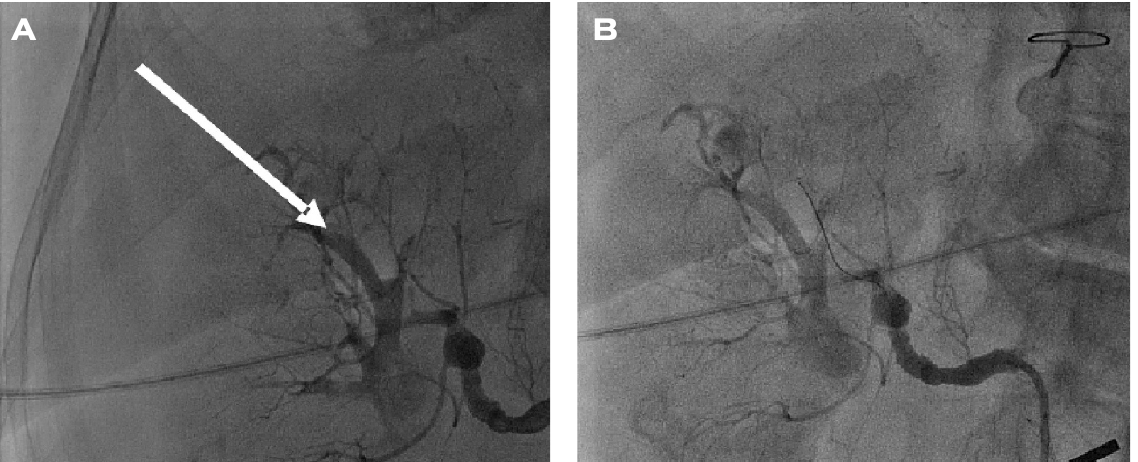
Figure 2. A. Emergency arteriography: ruptured branch of the upper pole renal artery (white arrow), contrast extravasation into pelveocalycal system of the right kidney shown. B. Emergency arteriography: a leader placed in the upper pole renal artery, pre-embolization